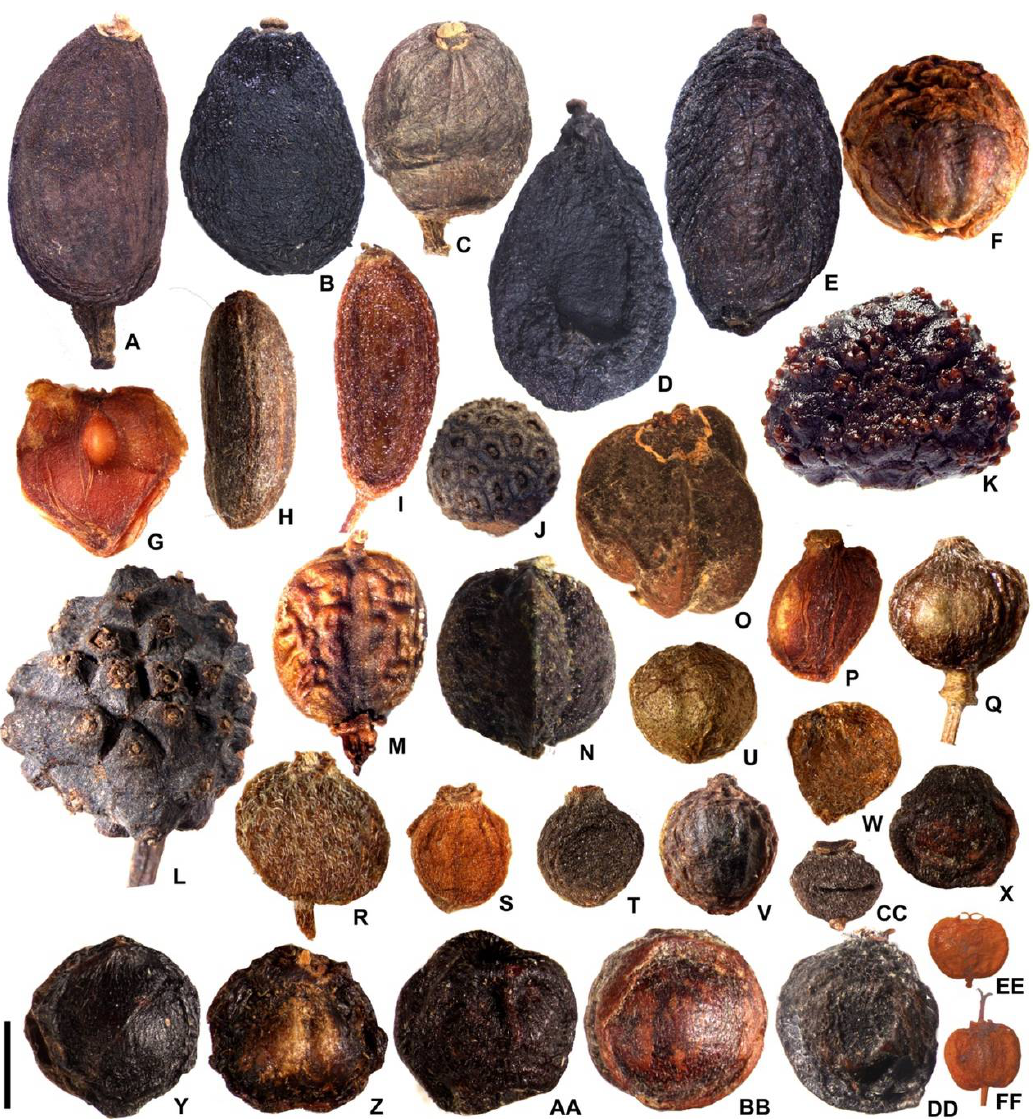
Figure 1. Fruit shape. ( A ) Aucuba chinensis var. angusta; ( B ) A. chinensis; ( C ) A. himalaica var. dolichophylla; ( D ) A. japonica; ( E ) A. obcordate; ( F ) Cornus controversa; ( G ) C. canadensis; ( H ) C. chinensis; ( I ) C. officinalis; ( J ) C. elliptica; ( K ) C. capitata; ( L ) C. hongkongensis; ( M ) Helwingia chinensis; ( N ) H. japonica; ( O ) H. omeiensis; ( P ) Cornus alba; ( Q ) C. alsophila; ( R ) C. bretschneideri; ( S ) C. hemsleyi; ( T ) C. koehneana; ( U ) C. macrophylla; ( V ) C. oblonga; ( W ) C. quinquenervis; ( X ) C. poliophylla; ( Y ) C. sanguinea; ( Z ) C. schindleri; ( AA ) C. ulotricha; ( BB ) C. walter; ( CC ) C. wilsoniana; ( DD ) Torricellia angulate; ( EE ) Heteropanax brevipedicellatus; ( FF ) Kalopanax septemlobus; scale bars = 4 mm in ( A – I ), ( K – X ), ( CC ); 6 mm in ( J ); and 3 mm in ( Y – BB , DD – FF ).